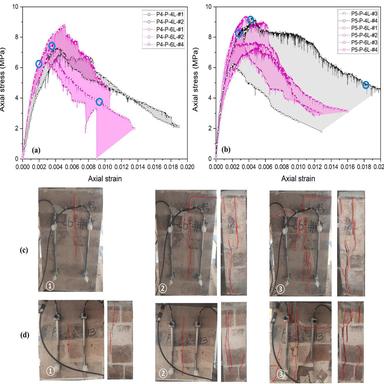
Axial stress versus axial strain under compression for 4-layer and 6-layer prisms extracted from P4(a) and P5(b); the evolution of rack pattern for the prism P4-P-6L-#2(c) and P5-P-4L-#3(d).